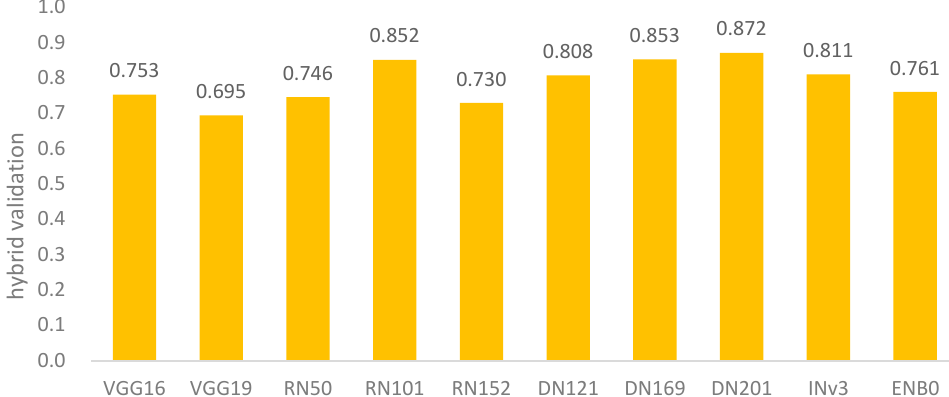
Figure 14. Training time of the recognition models.